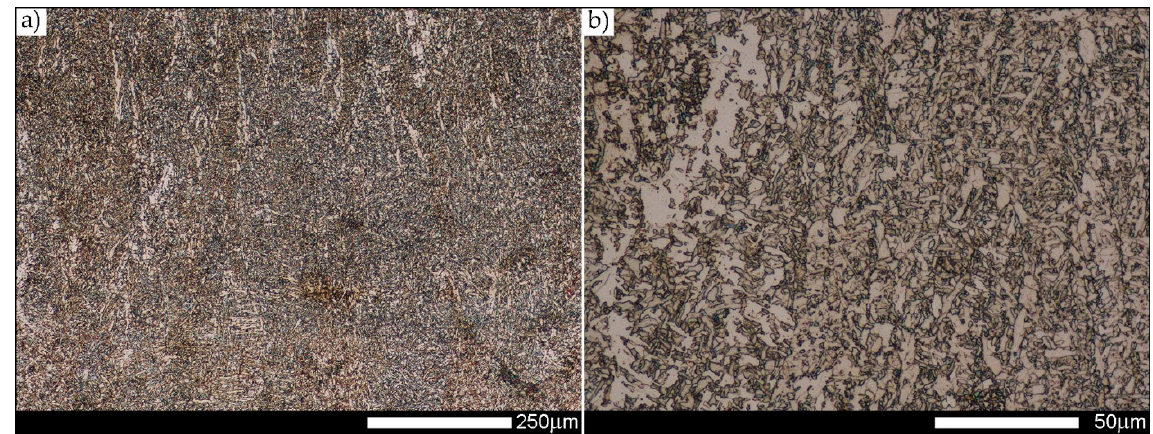
Figure 8. Microstructure of welded joint of Hardox 450 steel in delivery state (directly after welding)—WM3 zone shown in Figure 2a. ( a ) 100×; ( b ) 500×. Structure of non-equilibrium ferrite grains with very clear features of directional crystallisation. Light microscopy, etched with 3% HNO 3 .